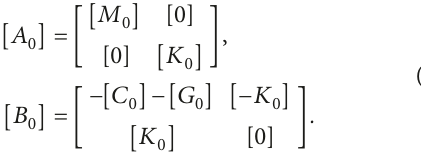
Figure 5 is an example of a damped, asymmetric system due to the presence of the gyroscopic damping matrix [ G